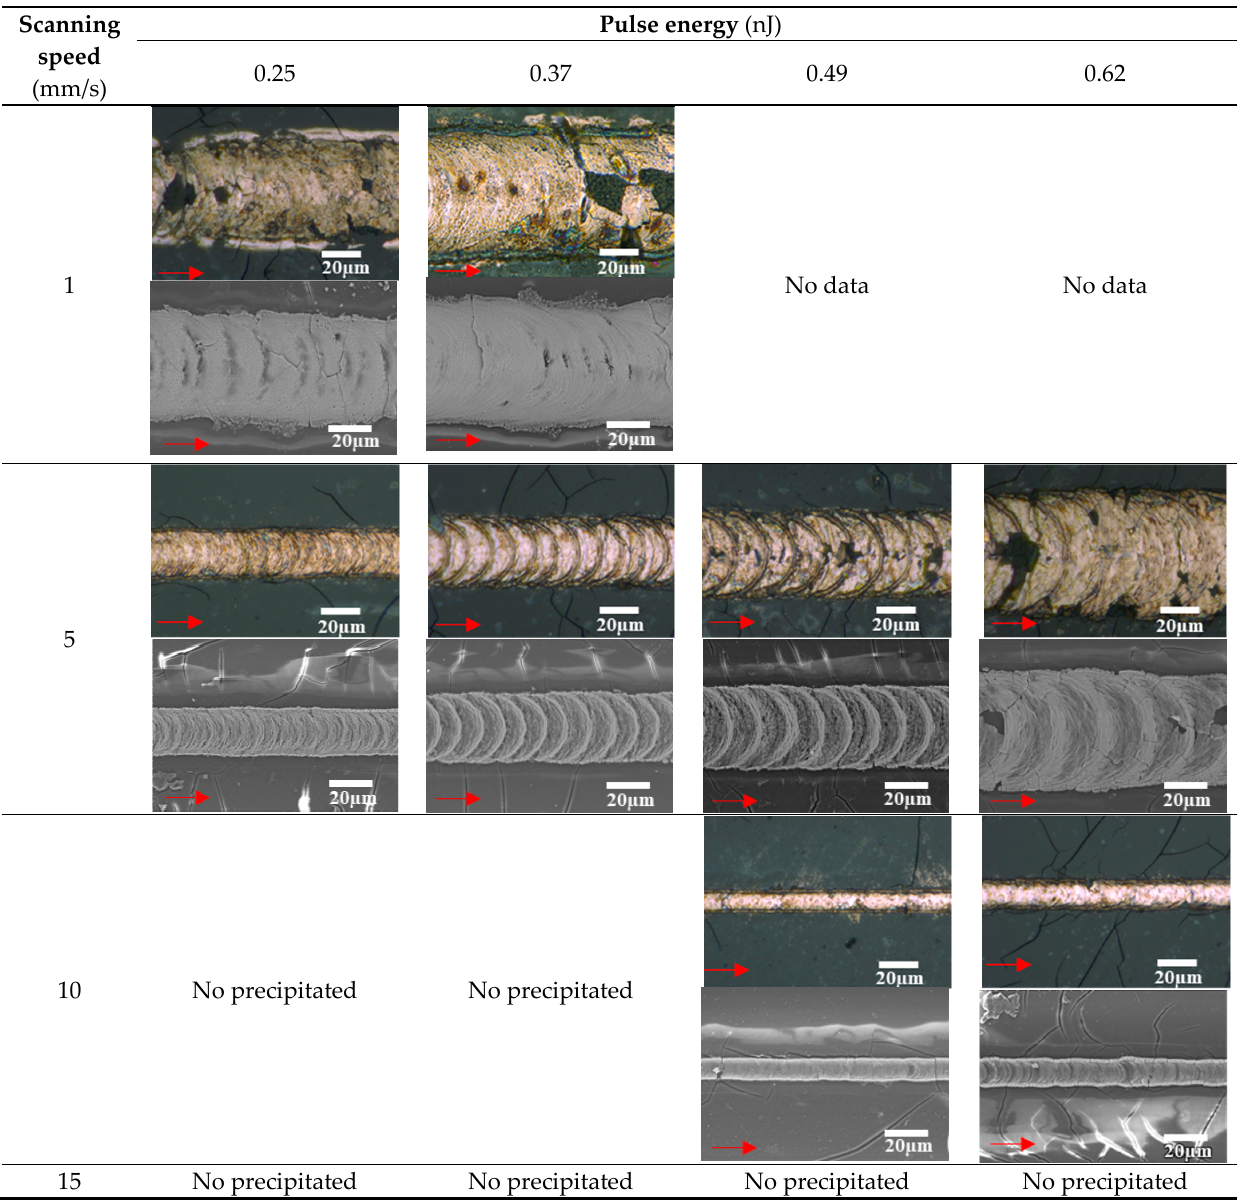
Figure 3. Optical and SEM microscope images on PDMS substrates at a scanning speed of 0.5 ‒ 10 mm/s and pulse energy of 0.25 ‒ 0.62 nJ.